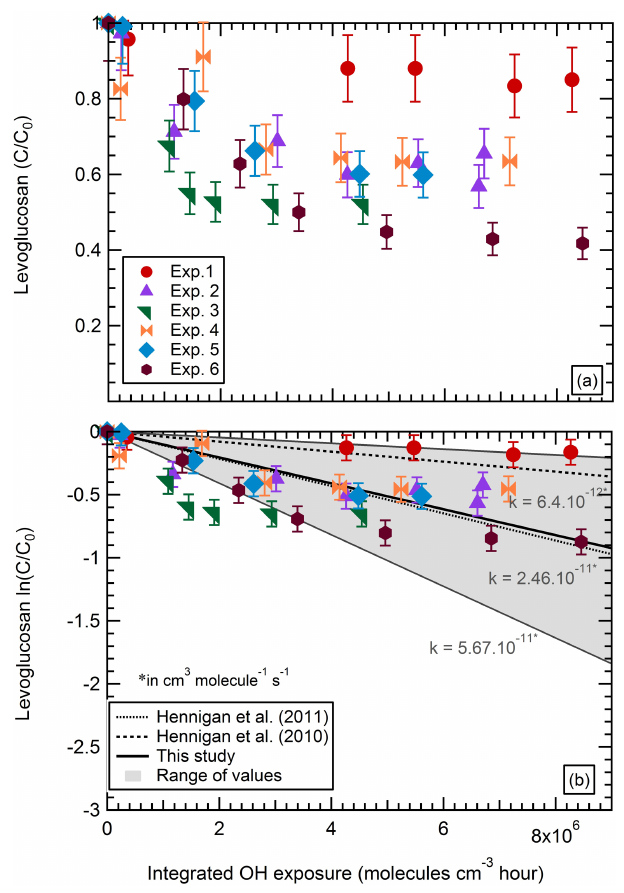
Figure 2. Particle wall-loss-corrected (pWLC) concentration of lev- oglucosan (normalized to its initial concentration) as a function of the integrated OH